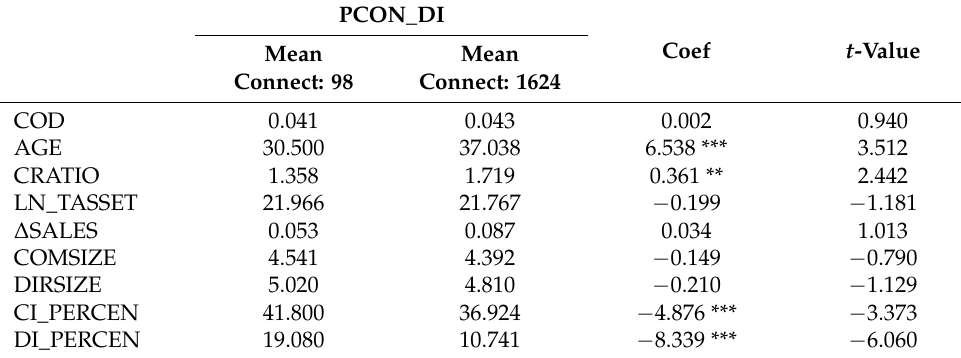
Table 7. Independent t -test of Variable Politically Connected Independent